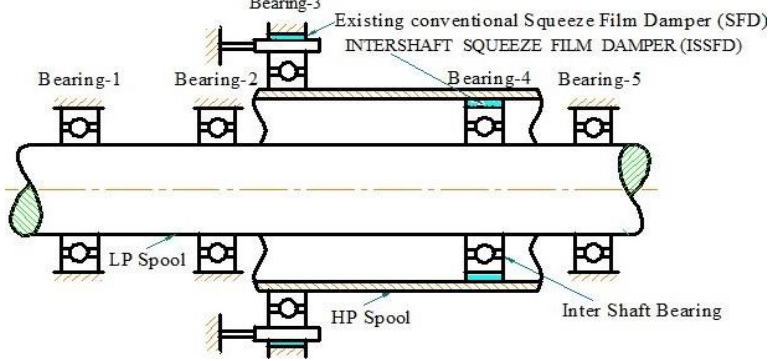
Figure 1: Schematic of a typical two spool configured gas turbine